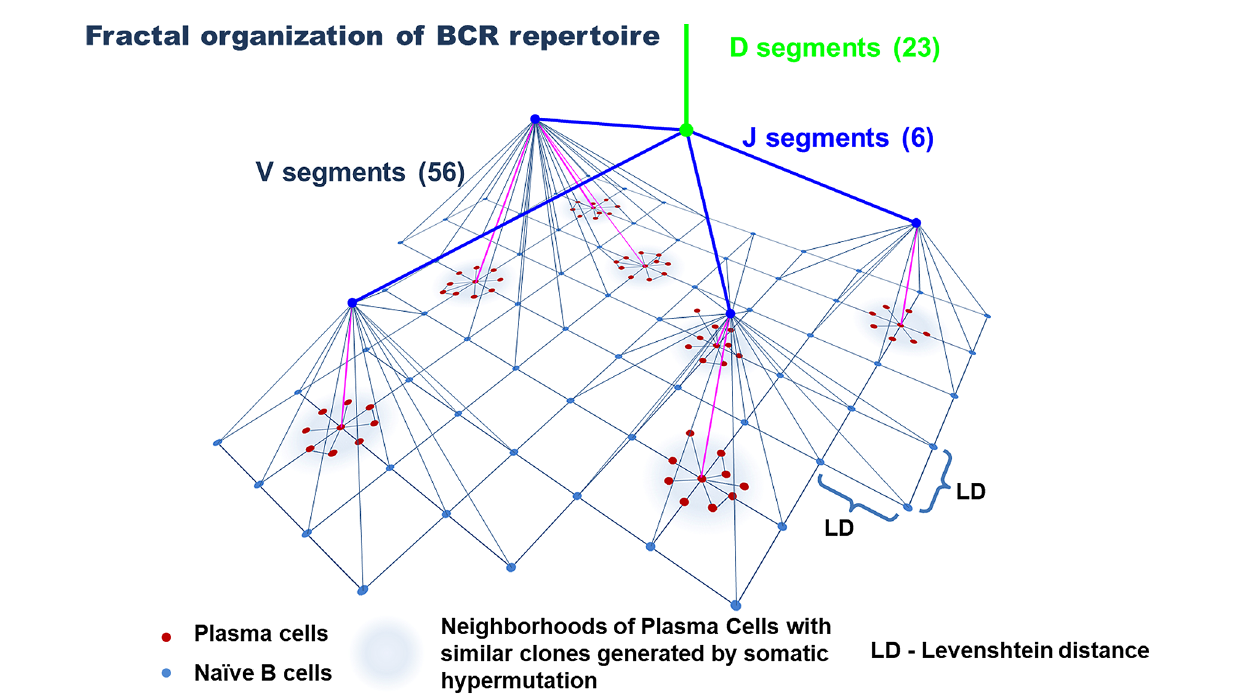
FIGURE 4 | Model of the organization of the B-cell repertoire. Tree-like structures generated by VDJ recombination and nucleotide additions/deletions and a star- like structure for plasma cells likely generated by somatic hypermutation. The uniform distribution of naive B cells in the similarity layer schematically re fl ects a homogeneously interconnected network (by Levenshtein distances) of these cells, in contrast to plasma cells, that form highly interconnected subnetworks of similar clones. The number of V, D, and J segments is indicated for the IgH